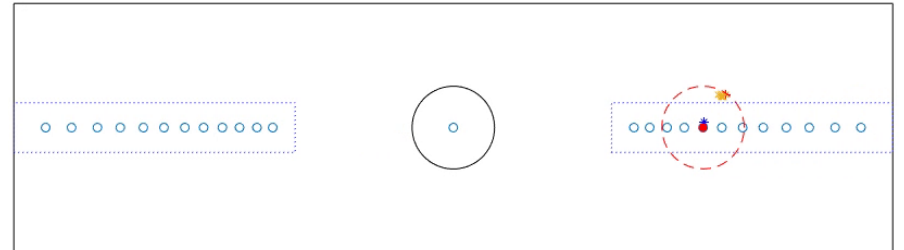
Figure 2. The interface implemented to review the recordings and to collect offline calibration points at different stages of the experiment. This image depicts a frame of a 2D representation of the testing display with the position of the visual target currently on screen (red dot), the initial estimated gaze points (yellow stars), and the new calibrated gaze coordinates (blue star).